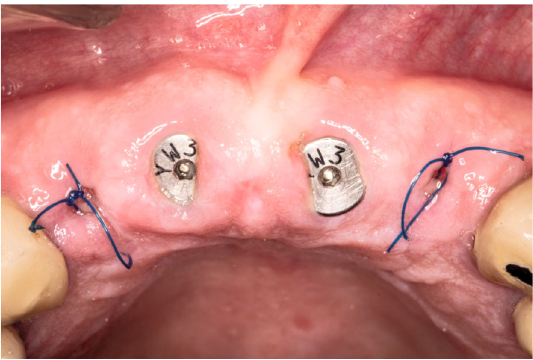
Figure 6: One-week